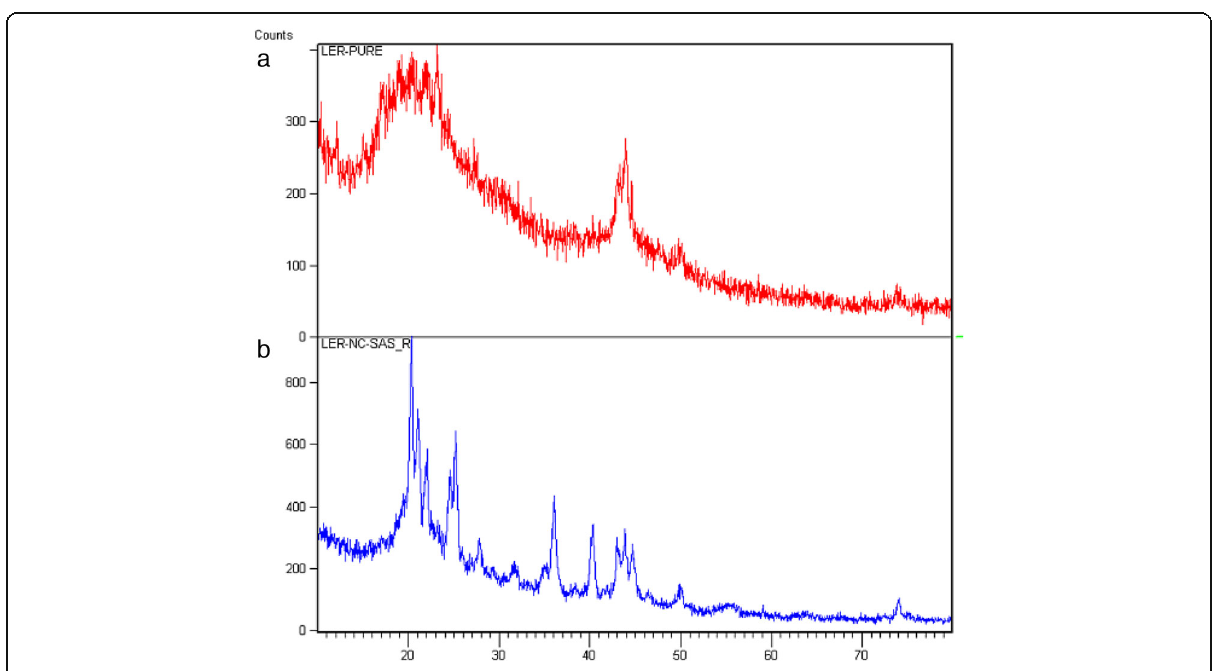
Fig. 8 XRD spectra of the a Lercanidipine and b Lercanidipine